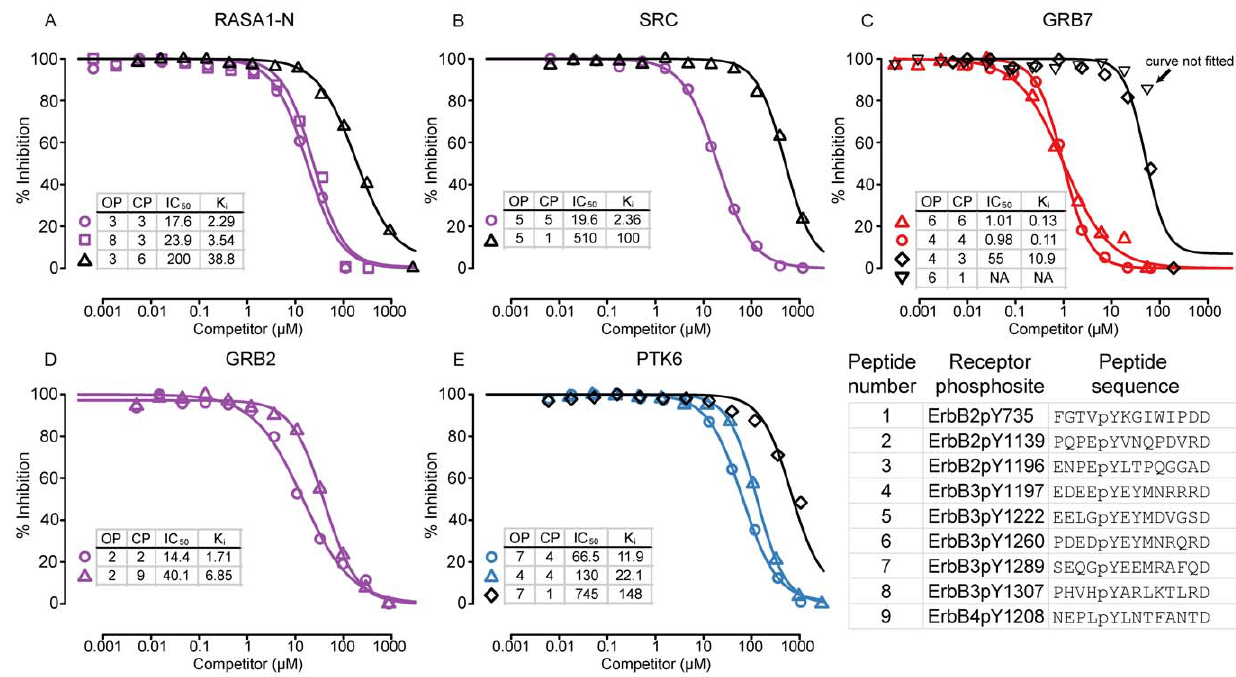
Figure 3. Competitive inhibition binding curves of protein-peptide interactions detected by FP. Nine ErbB phosphotyrosine sites were queried against five proteins: ( A ) RASA1-N, ( B ) SRC, ( C ) GRB7, ( D ) GRB2, and ( E ) PTK6. The predicted binding affinities of competitor peptide curves are color-coded as follows: red ( K D , 1), purple (1 # K D , 5), blue (5 # K D , 20), and black ( K D $ 20). ‘‘OP’’ refers to the original rhodamine-labeled peptides and ‘‘CP’’ to the unlabeled competitor peptides, which have been numbered in the figure with sequences.